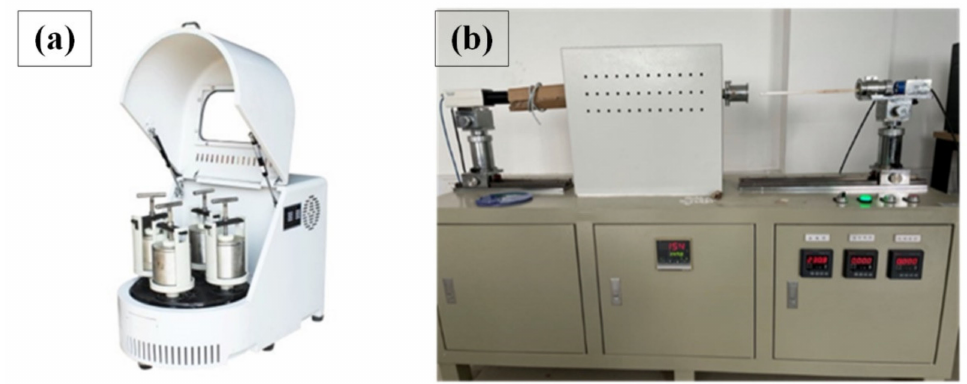
Figure 5. Devices used in melting point measurement experiment. ( a ) Ball milling machine; ( b ) melt- ing point measuring instrument.